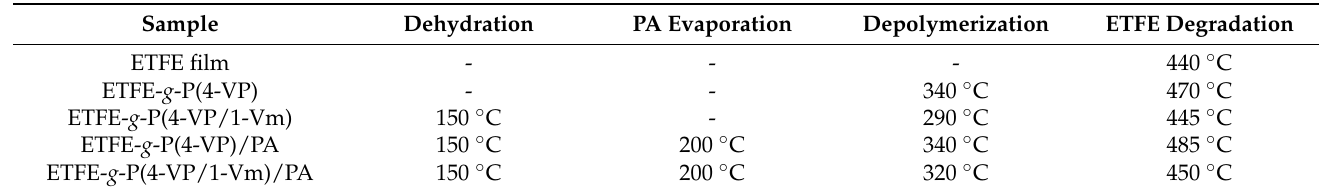
Table 1. TGA data of various degradation transitions of pristine ETFE film, ETFE- g -P(4-VP), and ETFE- g -P(4-VP/1-VIm) films compared to ETFE- g -P(4-VP)/PA and ETFE- g -P(4-VP/1-VIm)/PA membranes.